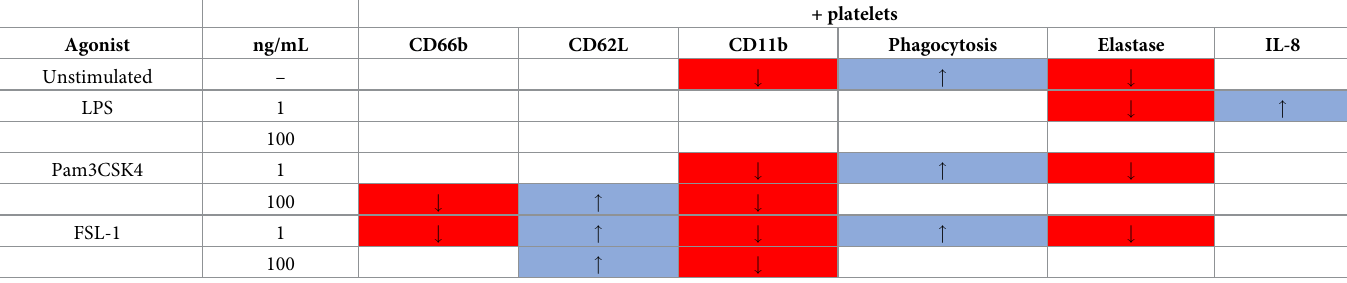
Red shaded/ # , relative change was statistically significantly decreased with platelets; Blue shaded/ " , relative change in marker was statistically significantly increased with the addition of